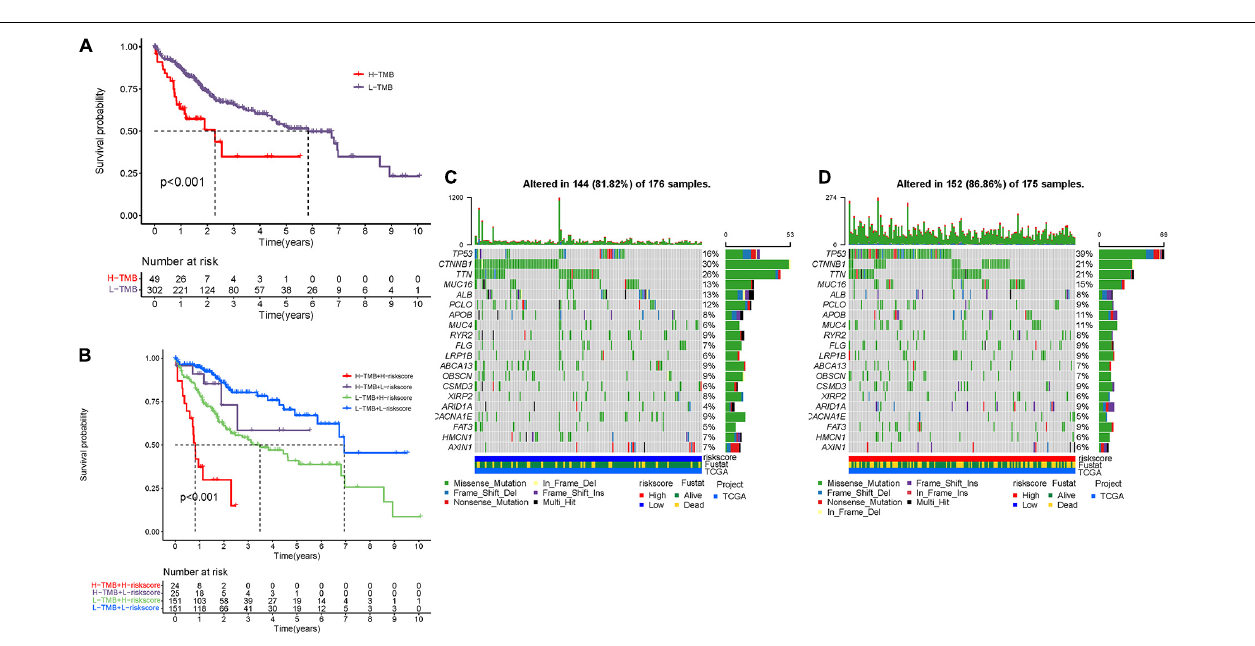
FIGURE 9 | The correlation between the risk score and TMB. (A) K-M curves for high and low TMB groups. (B) K-M curves for patients stratified by both TMB and risk score. The oncoPrint was constructed using low-risk score (C) and high-risk score (D)